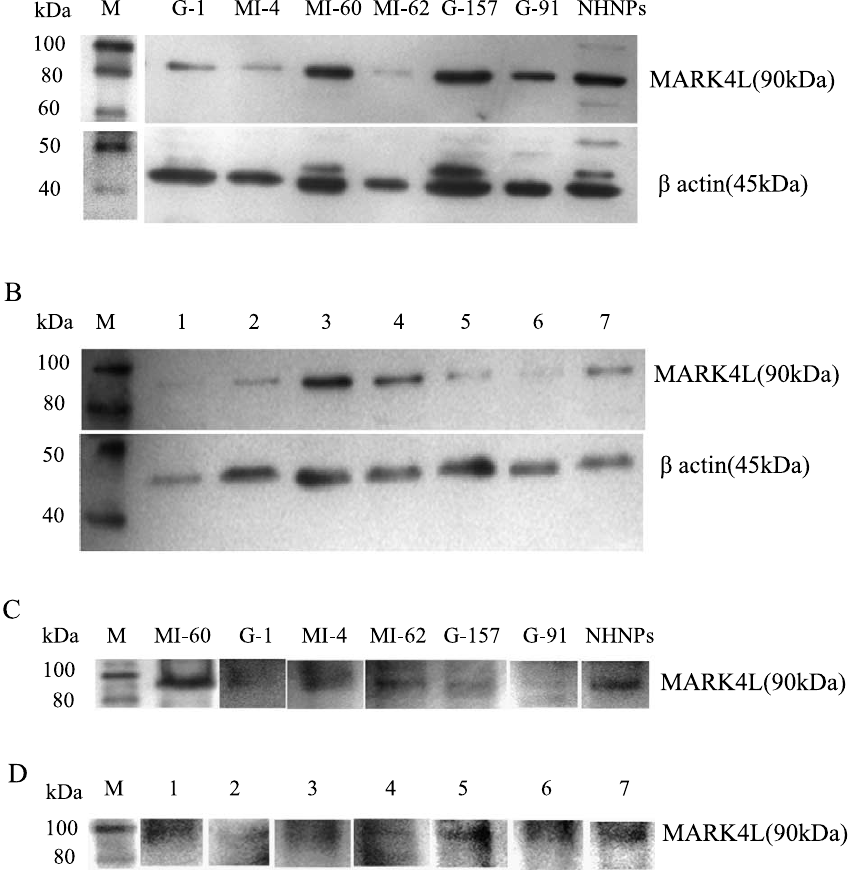
Fig. 1. (A) Immunoblots with anti-MARK4L antibody on a panel of whole cell lysates from glioma cell lines G-1 (GCGBM), MI-4, MI-60 (GBM), MI-62 (AOA), G-157 (OA) and G-91 (A), and normal human neural progenitor cells (NHNPs). (B) Immunoblots with anti-MARK4L an- tibody on cell lysates from fresh gliomas 2 (A), 1, 4, 6, 7 (O), 3 and 5 (GBM). The samples were normalized using β -actin. (C and D) Immunoblots with anti-MARK4L antibody on whole cell lysates from the glioma cell lines and fresh gliomas, immunoprecipitated with anti-MARK4L anti- body. M: molecular weight ladders